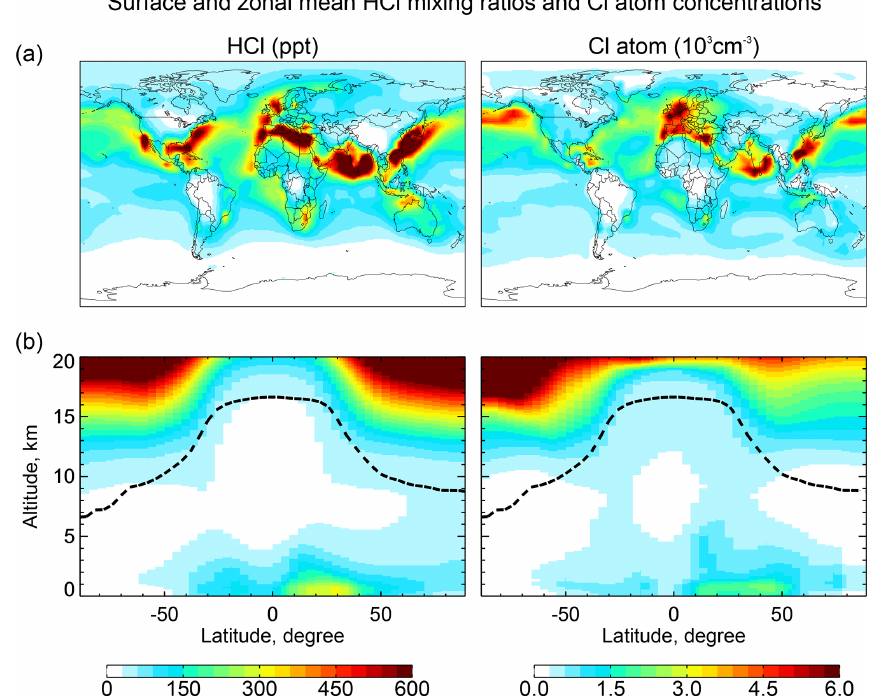
Figure 2. Global distributions of annual mean HCl mixing ratios and Cl atom concentrations in GEOS-Chem. Panel (a) shows surface air mixing ratios and concentrations. Panel (b) shows zonal mean mixing ratios and concentrations as a function of latitude and altitude. Dashed lines indicate the tropopause.